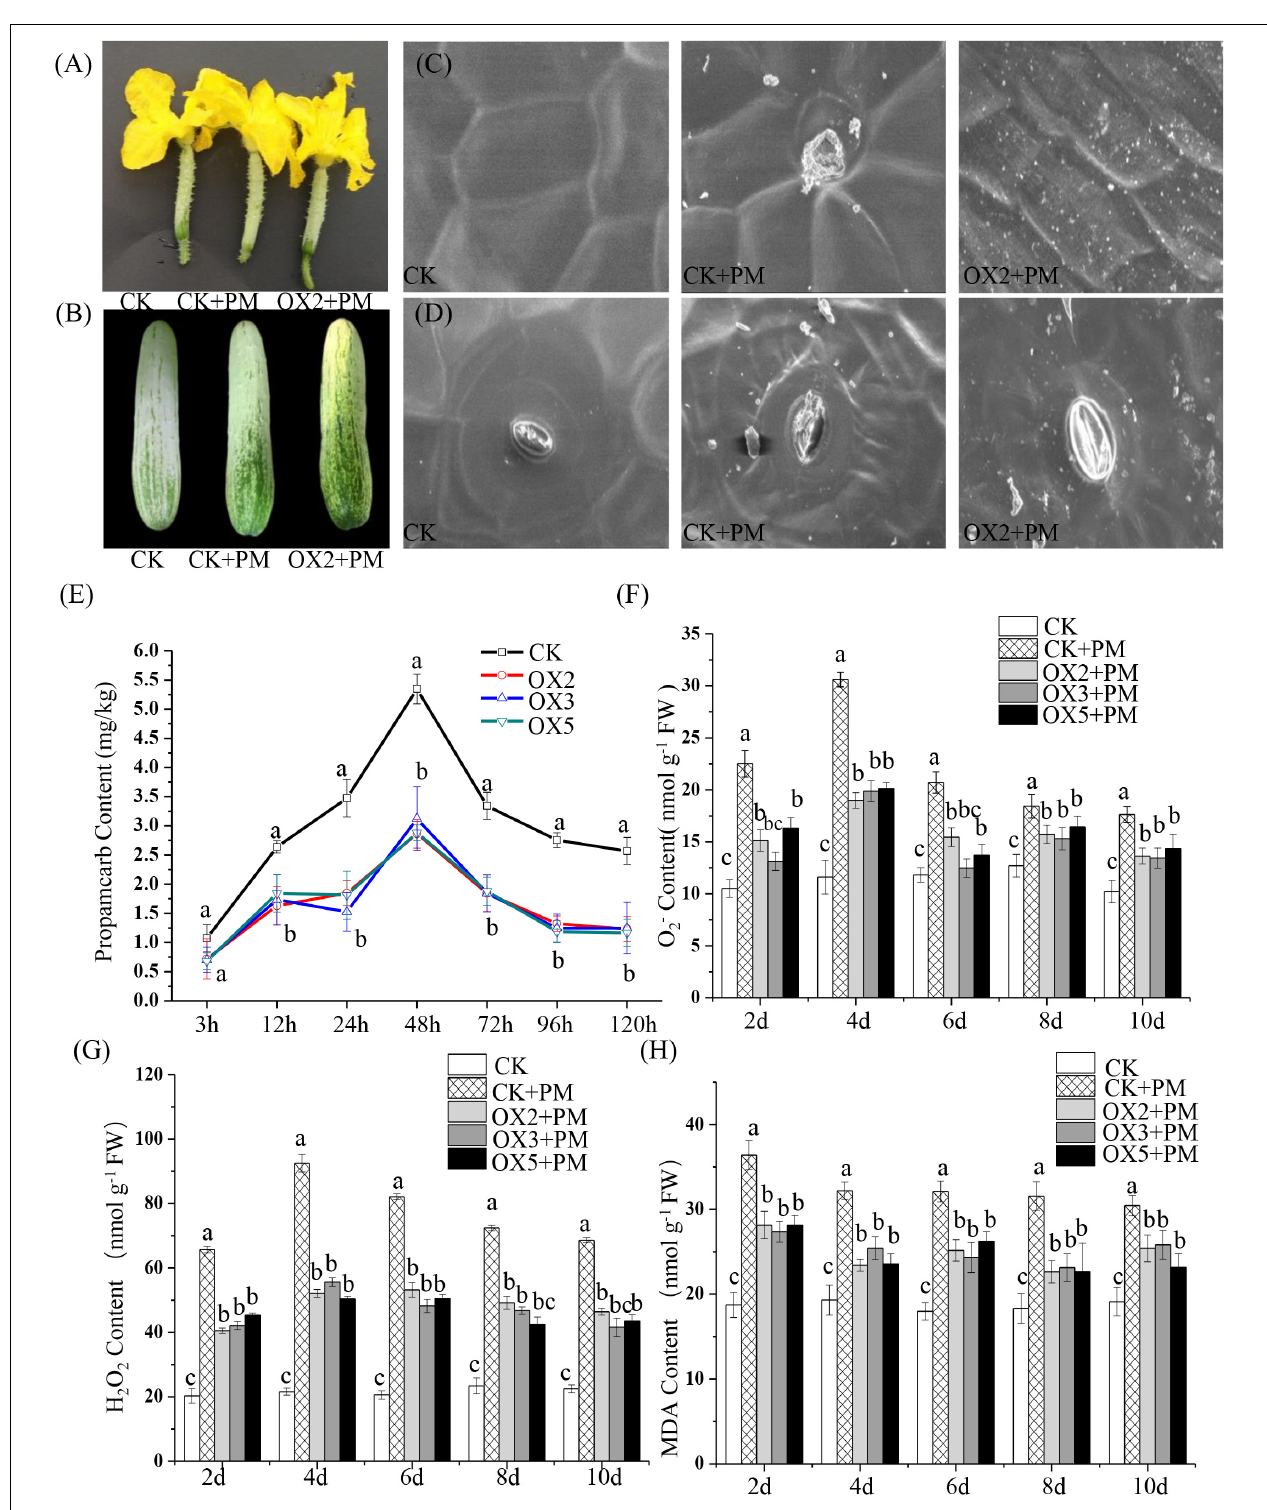
FIGURE 8 | Effects of CsHMGB on propamocarb residues and phytotoxicity in “D9320” plants. (A) Phenotypes of fruits from the control (Col) and CsHMGB overexpressing (OX) plants at 4 days post anthesis (DPA). (B) Phenotypes of fruits from Col and OX plants at 12 DPA. (C) The accumulation of waxiness on epidermal cells in fruit peels. Bars of 20 µ m. (D) The opening of the stomatal aperture in fruit peel. Bars of 20 µ m. (E) Propamocarb contents in fruit peels under propamocarb stress with time course of 3, 12, 24, 48, 72, 96, and 120 h. (F–H) O 2 − , H 2 O 2 , and MDA contents in leaves under propamocarb stress with time course of 2, 4, 6, 8, and 10 days. Data are the means of three replicates with SEs, and different letters indicate a significant difference ( p < 0.05 by Tukey’s test).